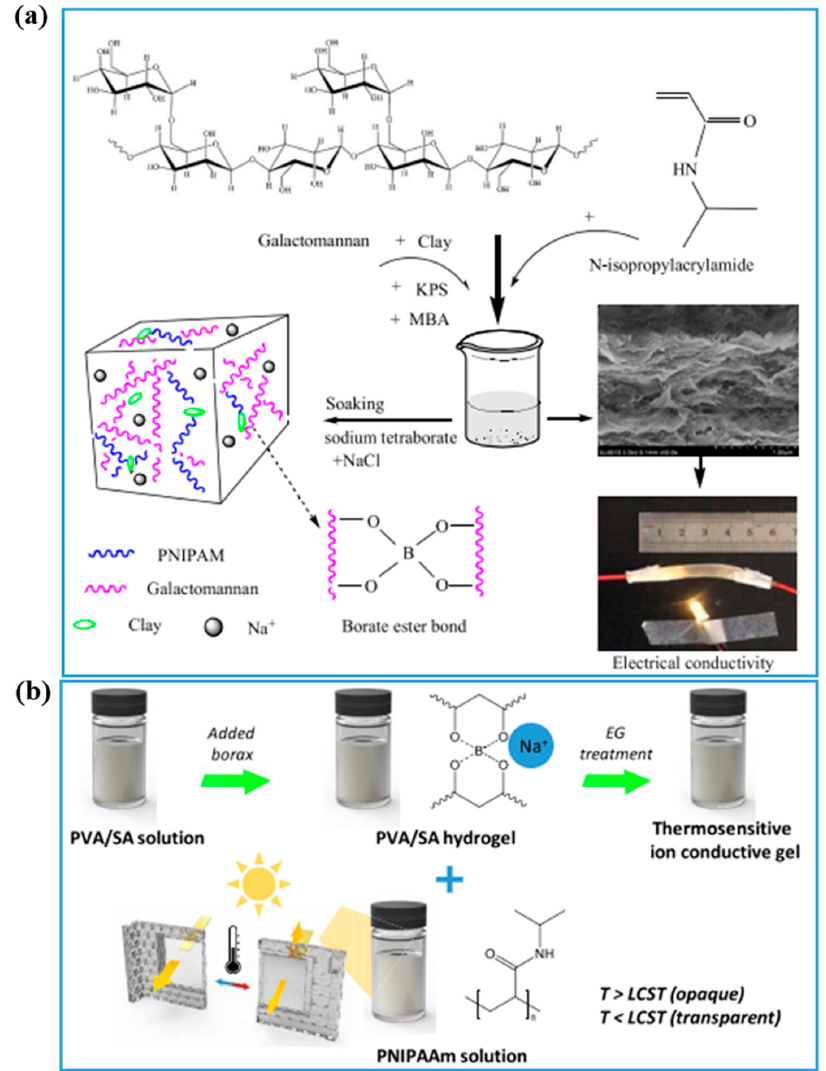
Figure 8. ( a ) Illustration of preparation process of PNIPAM-ECH with Na + served as